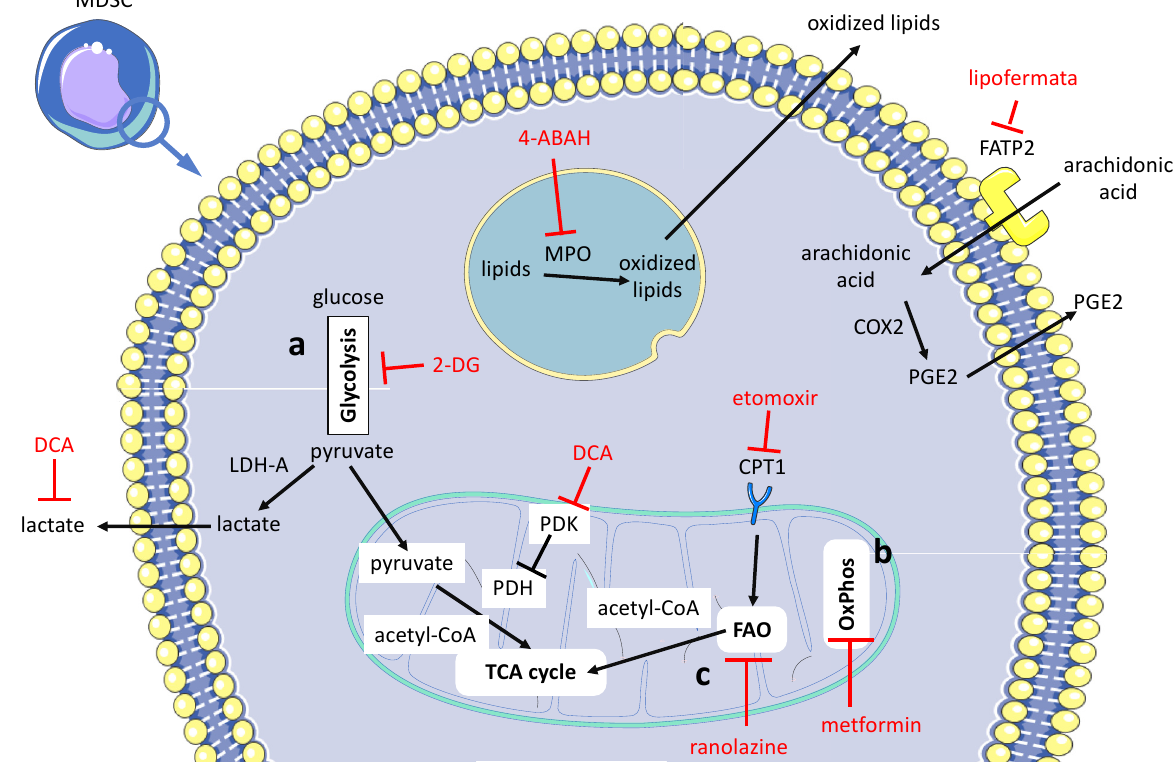
Figure 3. Pharmacological treatments aimed at counteracting in the TME the immunosuppressive activity of granulocytic MDSCs’ three main targets. ( a ) Dampening glycolysis [107,108], ( b ) restraining OXPHOS [109] and ( c ) hindering/modulating lipid metabolism through FAO inhibition [110], inhibition of arachidonic acid uptake [111] and inhibition of lipid peroxidation [112]. The cell targets of drug treatment are: PMN-MDSCs [109,111,112]; both PMN-MDSCs and M-MDSCs [108,110], and the whole MDSC cell population [107,113]. Therapeutic interventions are outlined in red. For explanation of acronyms and further details, refer to the text. Lipid peroxidation by MPO occurs in lysosomes.